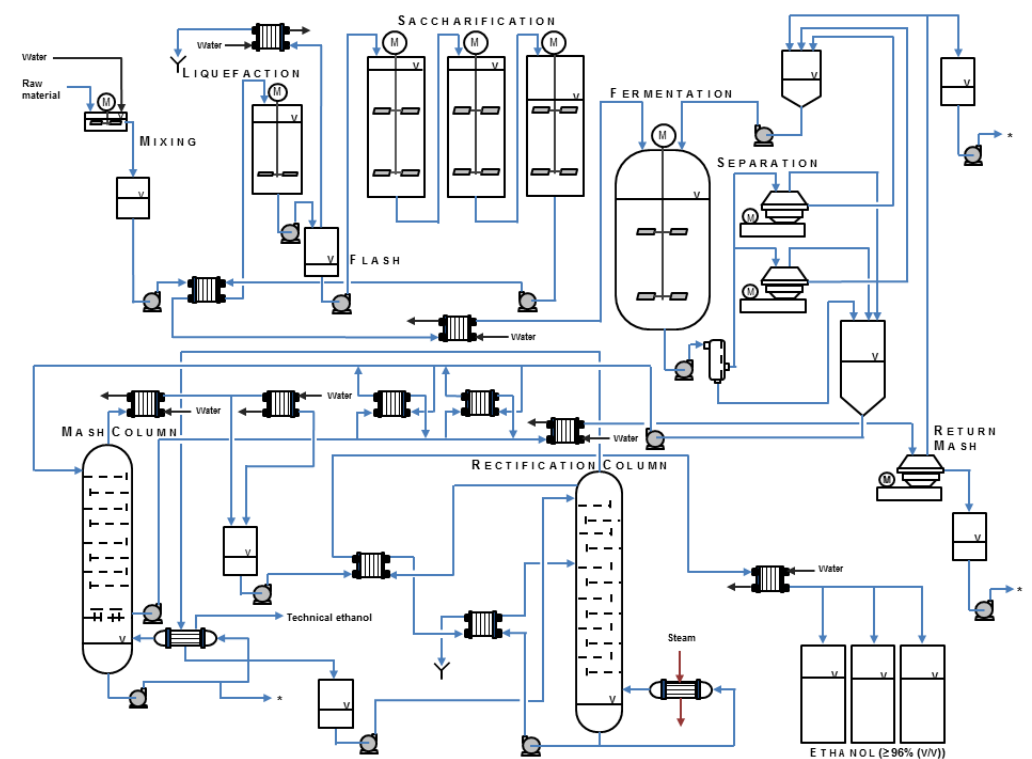
Figure 2. The process flow diagram of the plant showing the enzymatic conversion of starch and flour by liquefaction and saccharification, followed by fermentation, filtration, centrifugation and two-stage distillation. The effluents from the centrifuges and mash column are recycled to the fermentation stage, thereby enhancing high yield of ethanol from the raw materials stream ( * : storage